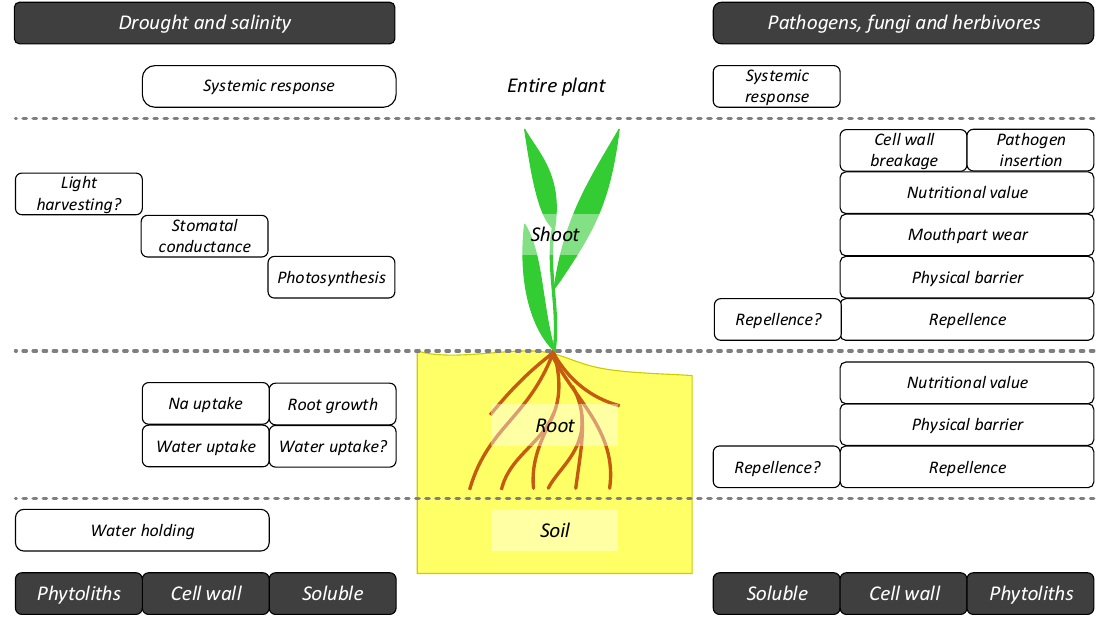
Figure 3. Form, location and function of Si in plant protection from drought and salinity (left) and from pathogens, fungi and herbivores (right).